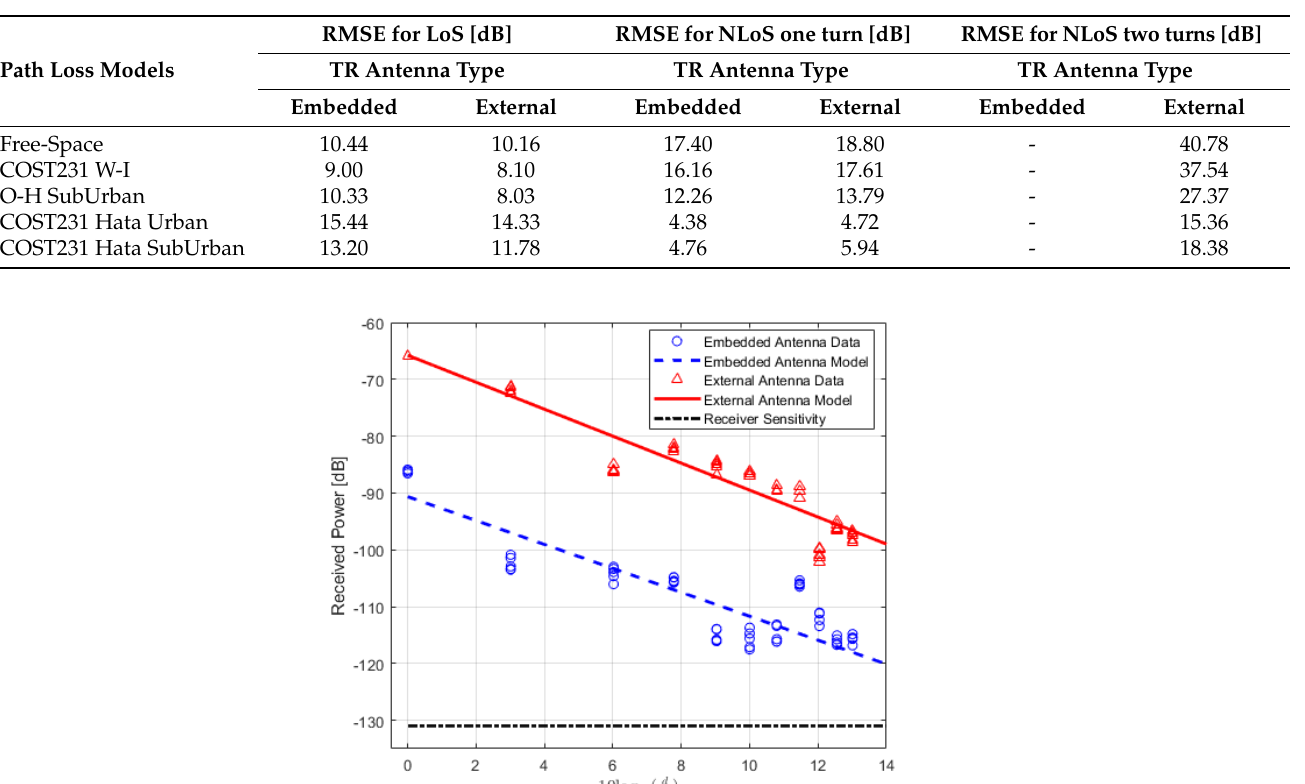
Table 12. Comparison of IQRF models with empirical models of Section 3.